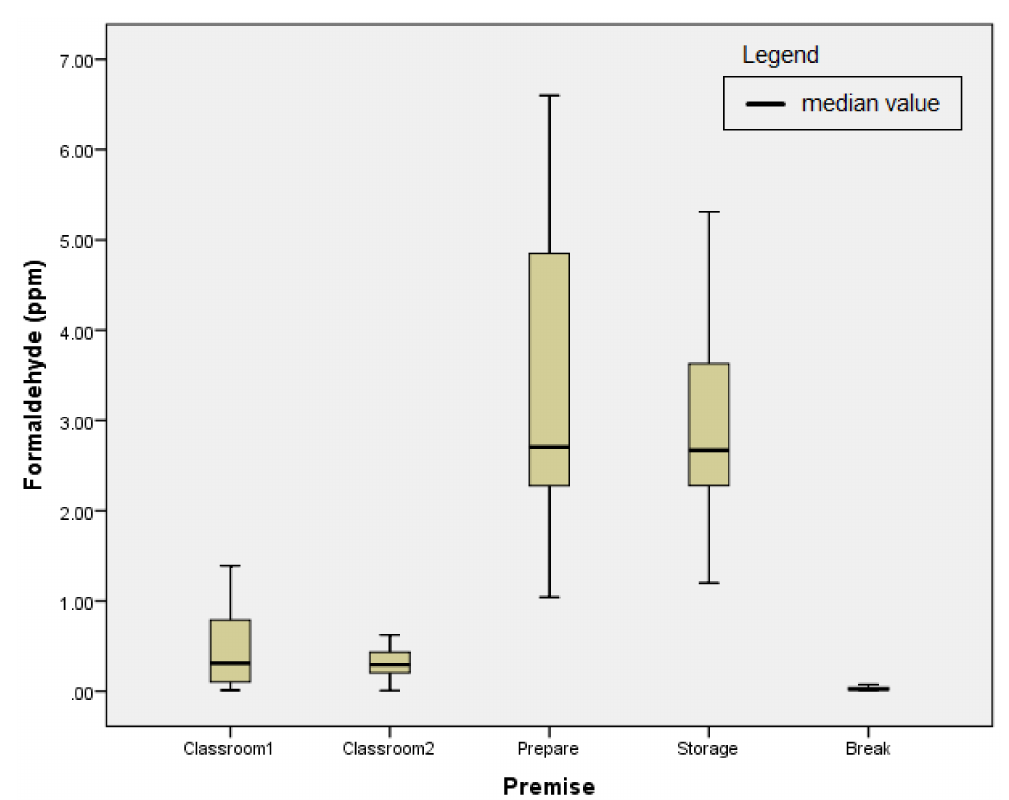
Figure 3. The results of the third sampling